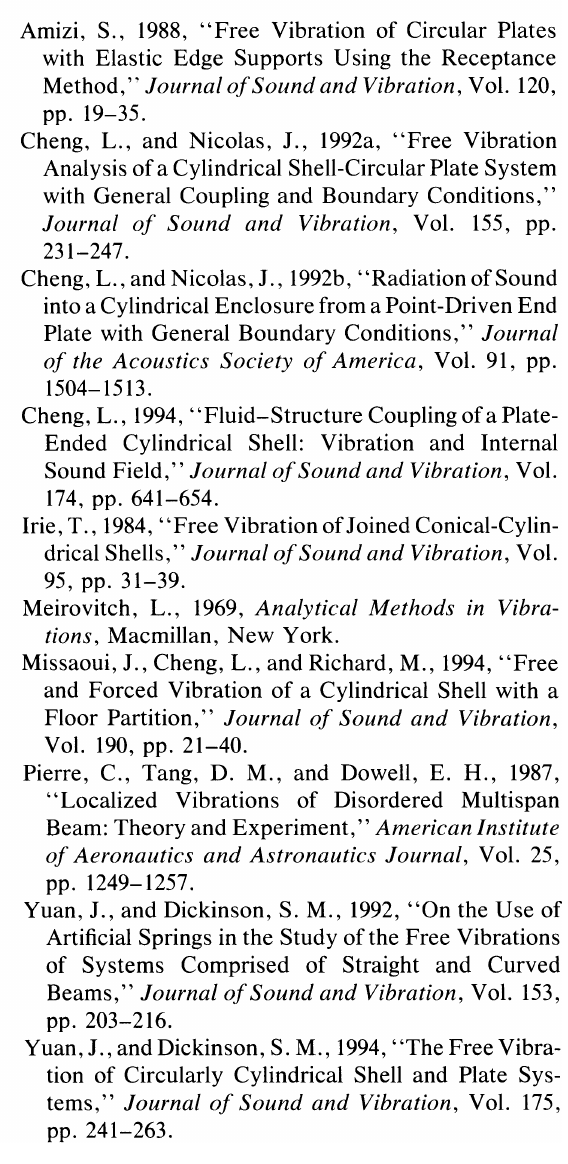
FIGURE 12 Quadratic velocity ofthe vessel contain- ing